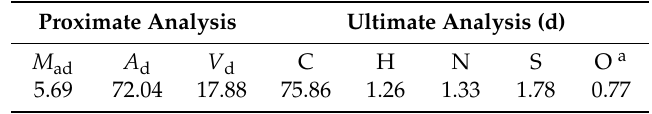
Table 3. Proximate and ultimate analyses of Yongding Fujian anthracite [31].